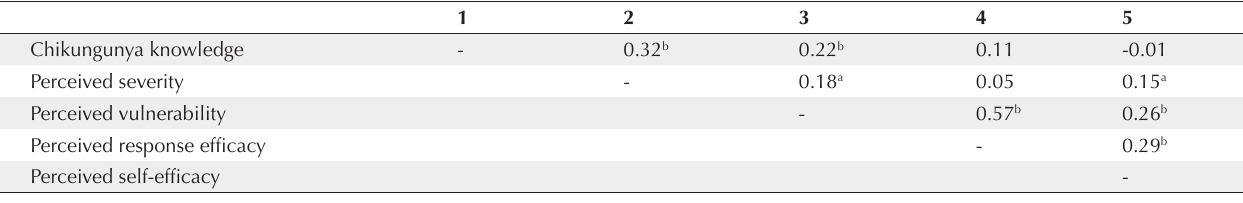
Table 1. Pearson Product-Moment Correlations Between Chikungunya Knowledge, Perceived Severity, Perceived Vulnerability, Response Efficacy, and Self-efficacy